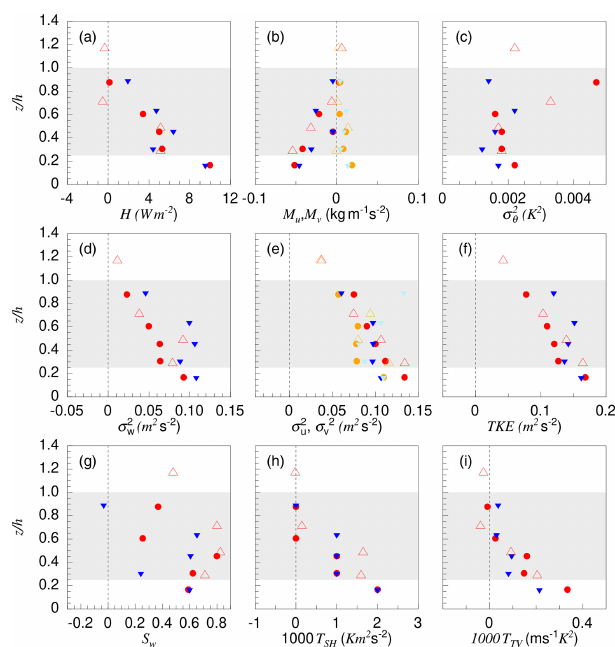
Figure 10. Turbulence statistics based on horizontal flight legs of 14 June 2017 obtained from Polar 5 (closed symbols) and Polar 6 (open symbols). Results of Polar 5 refer to the two northernmost dashed blue legs shown in Fig. 8. The Polar 6 result refers to its northernmost flight leg (red in Fig. 8). Altitude is normalized by the cloud-top height, h = 400m. The bright symbols (light blue and orange) refer to M v and σ 2 v , while the dark (red and blue) symbols in the corresponding panels refer to M u and σ 2 u